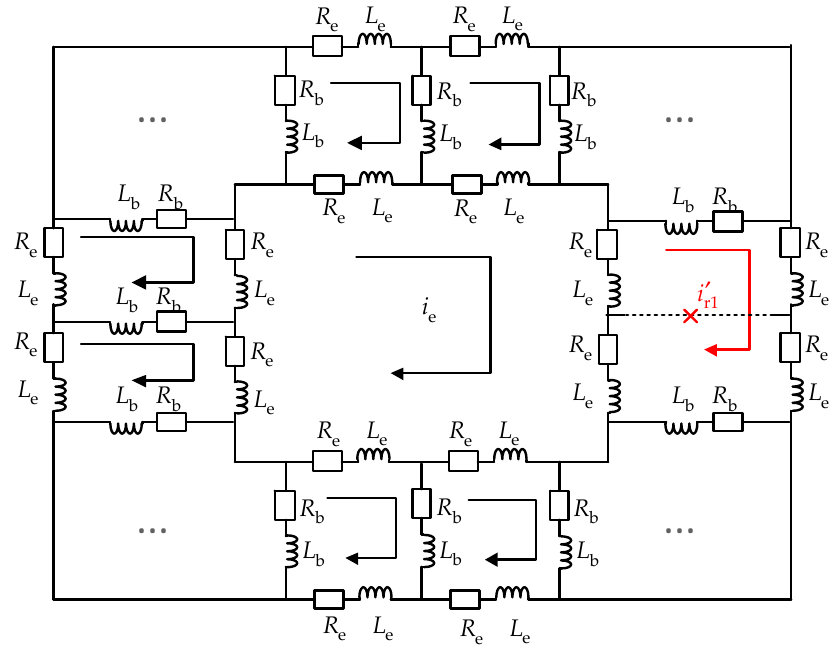
Figure 3. Representation of the rotor cage mesh when the first rotor bar is broken.